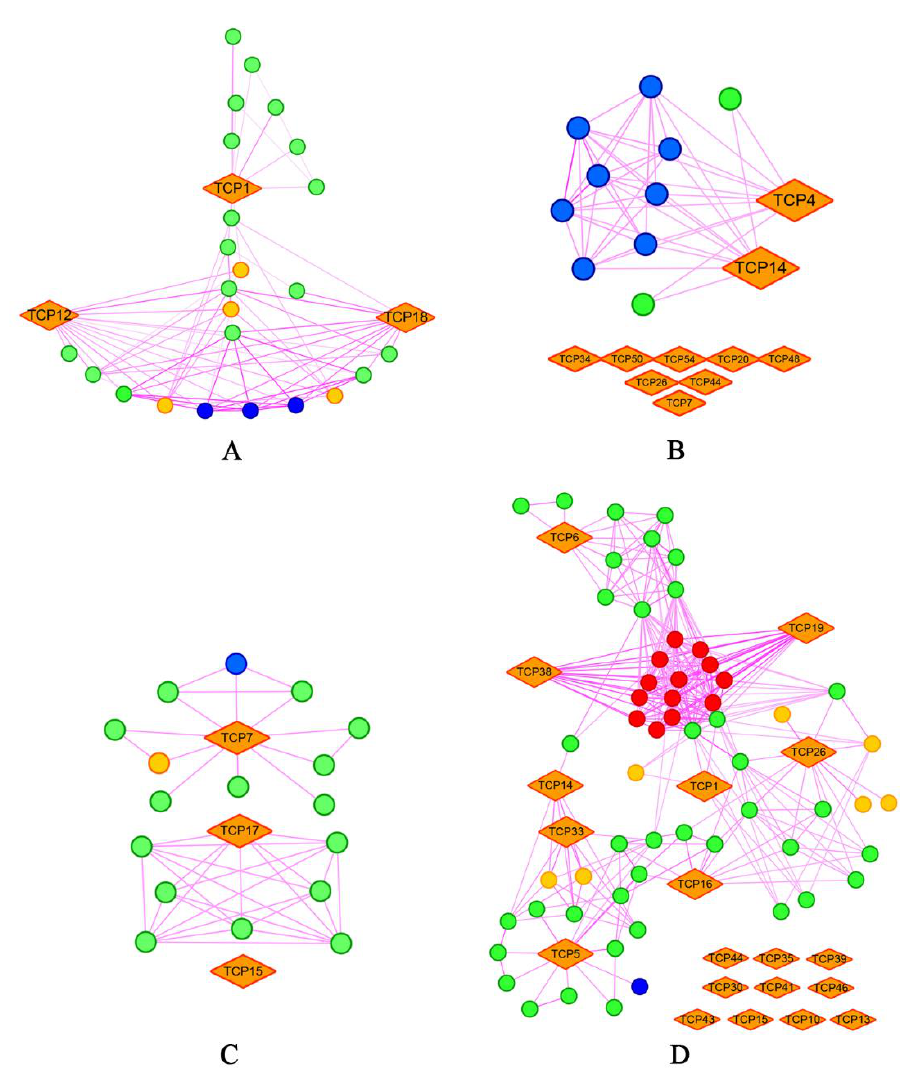
Figure 6. Interaction network of TCP proteins within the CYC clade in ( A ) Arabidopsis thaliana , ( B ) Glycine max , ( C ) Oryza sativa , and ( D ) Zea mays according to the STRING dataset [55]. The interaction network was constructed in Cytoscape 3.6.1 [62]. CYC proteins are displayed as orange rhombs. Light orange circles represent other TCP proteins. Blue circles indicate proteins involved in the strigolactone pathway. Red circles represent the Hsp70 domain-containing proteins.